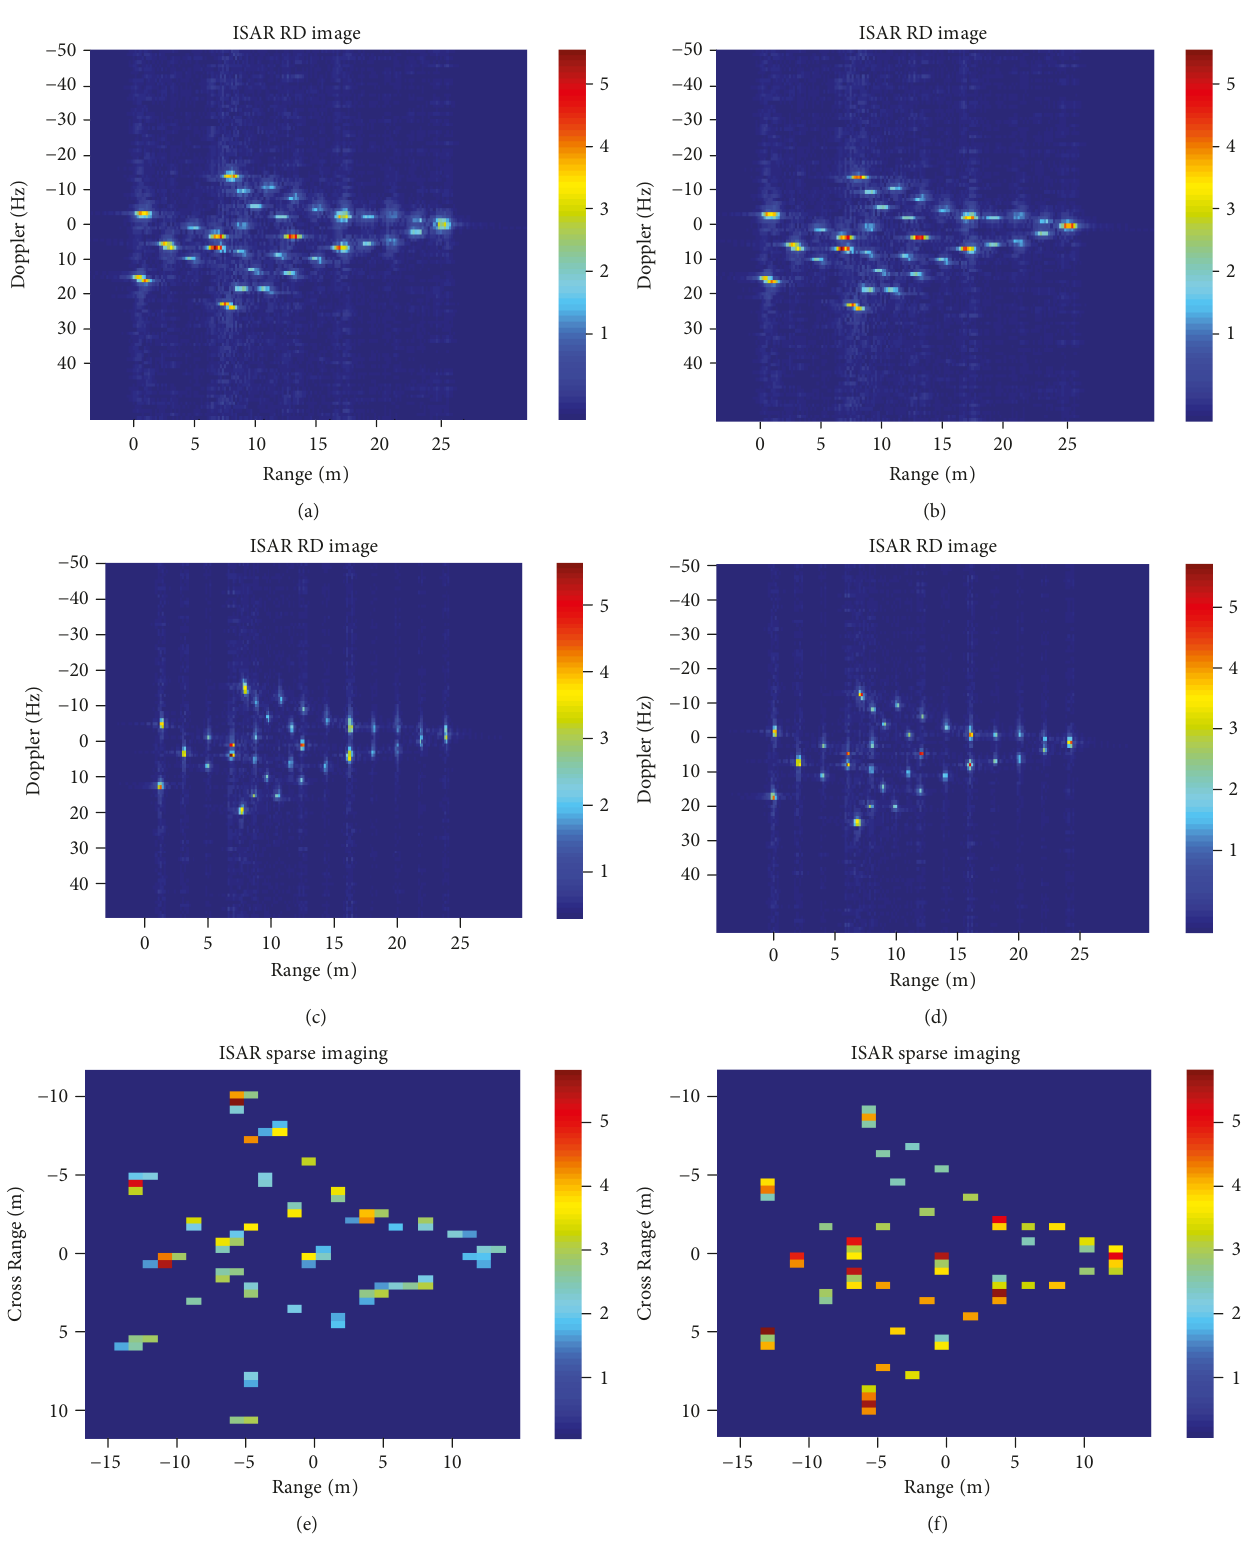
Figure 6: The imaging result: (a) RDA result without speed or Doppler compensation; (b) RDA result without speed compensation; (c) RDA result without Doppler compensation; (d) RDA result with joint speed and Doppler compensation; (e) sparse imaging result without speed or Doppler compensation; and (f) sparse imaging result with joint speed and Doppler